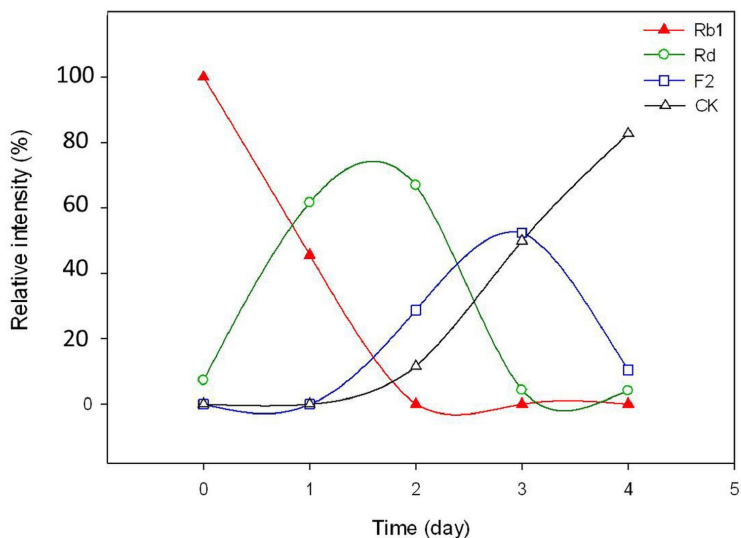
Figure 9. Time course for content variation of ginsenoside Rb1, Rd, F2 and CK during the